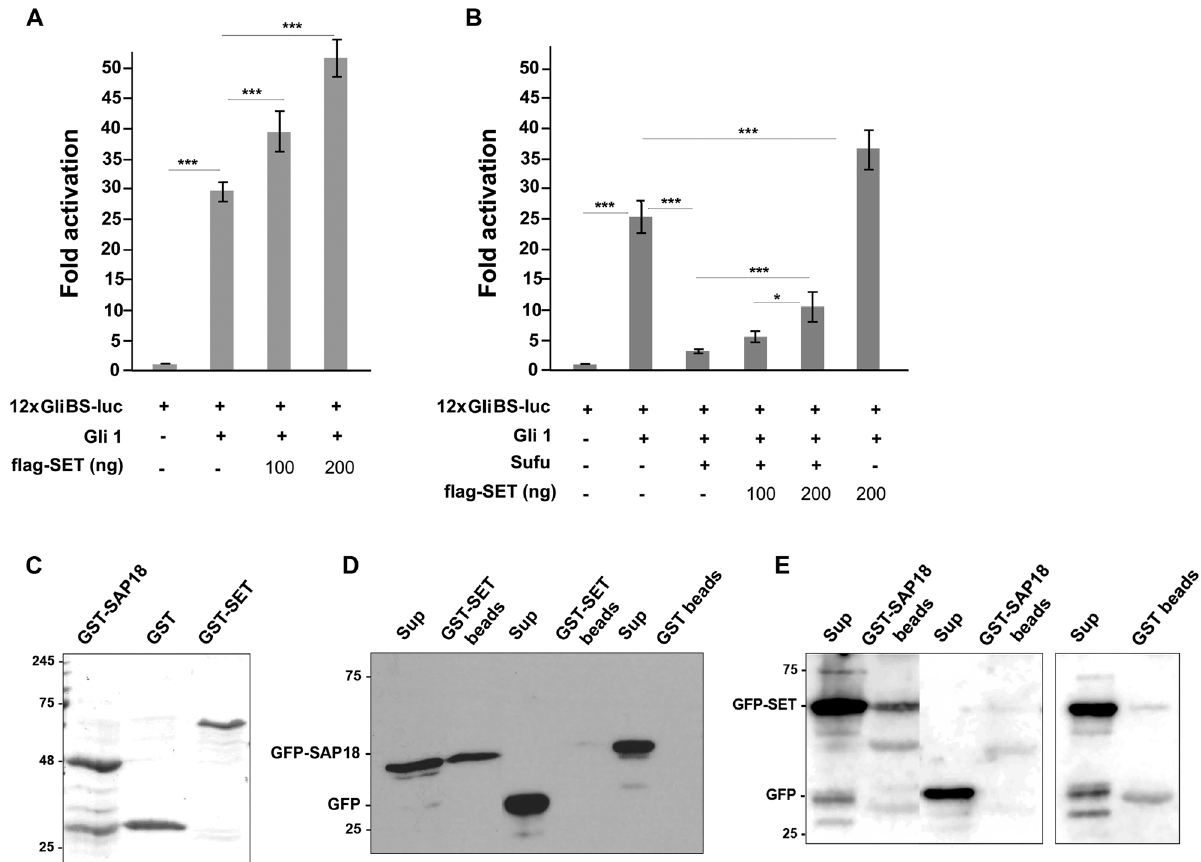
Figure 5. SET overexpression increases Gli1-mediated transcription. ( A ) The effect of SET on Gli1-mediated transcription. To determine Gli1-mediated transcription upon SET overexpression, 12xGliBS-luc and Gli1 expression plasmids were cotransfected with a human Flag-SET expressing construct in HEK 293 cells. ( B ) The effect of SET on Sufu inhibition of Gli1-mediated transcription. HEK 293 cells were transfected with 12xGliBS-luc reporter with the indicated amounts of plasmids encoding Gli1 (100 ng), Flag-SET (100 and 200 ng) and Sufu (10 ng). pRL-TK expresses Renilla luciferase and was included in all samples to normalize the transfection efficiency. Experiments were repeated three times and samples were analyzed in triplicates, *p < 0.05, **p < 0.01, ***p < 0.001. ( C ) Expression of GST-SET and GST-SAP18 recombinant proteins. Bacterially expressed glutathione-S-transferase-tagged SAP18 (GST-SAP18), GST protein and baculovirus expressed GST-SET (approximately 2–3 μg each) were immobilized on glutathione-Sepharose beads and analyzed by 12% SDS-PAGE. An original uncropped image of panel C is shown in Supplementary Fig. 2S. ( D ) GST-SET pull down experiments. GST-SET or GST was immobilized on glutathione-Sepharose beads and incubated with cell extracts expressing GFP-SAP18 or GFP. ( E ) GST-SAP18 pull down experiments . GST-SAP18 or GST was immobilized on glutathione-Sepharose beads and incubated with cell extracts expressing GFP-SET or GFP.